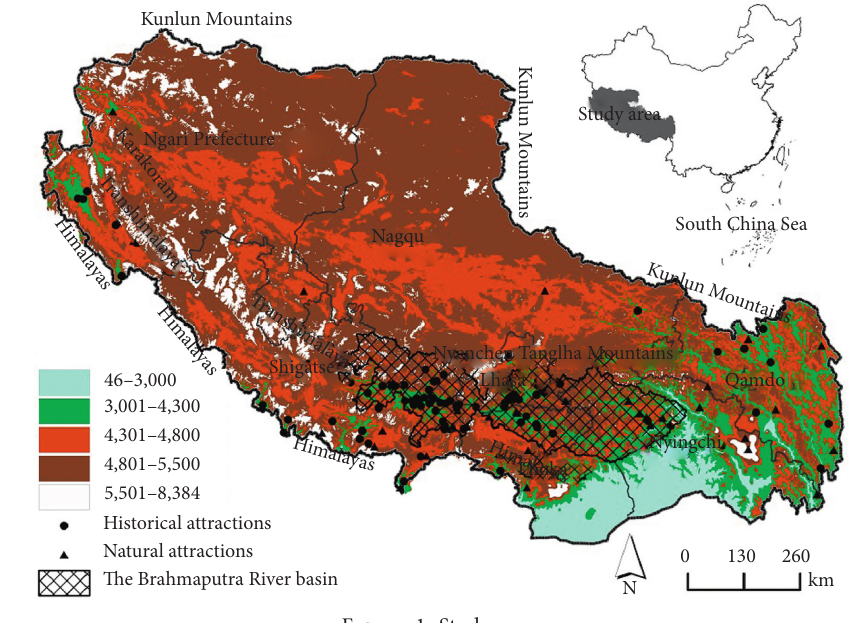
Figure 1: Study area. Table 1: Evaluation index system of AT and TD.